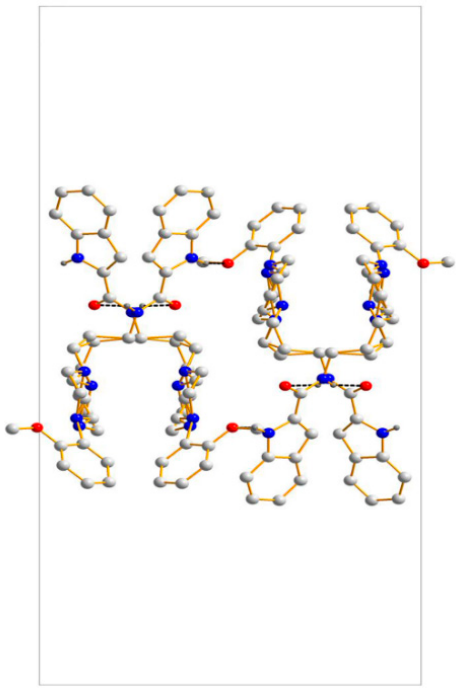
Figure 7. Crystal packing of 3 along the c axis. Black dashed lines show the intermolecular H-bonds. Table 5. Intermolecular hydrogen bonds for compound 3 (Å, °).